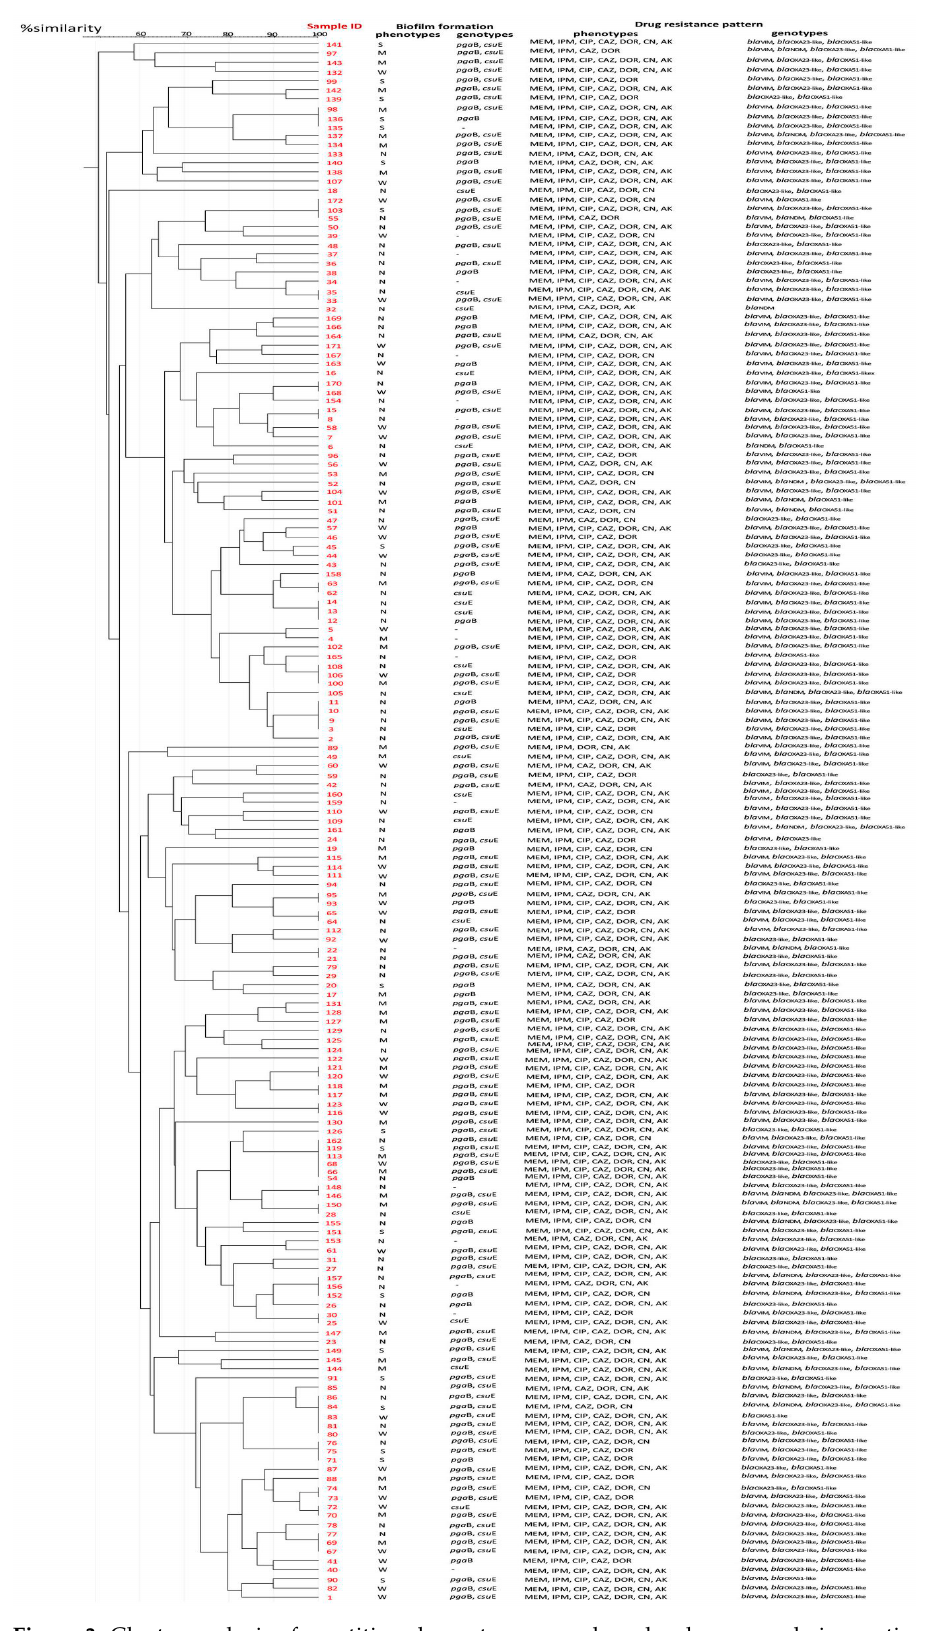
Figure 3. Cluster analysis of repetitive element sequence-based-polymerase chain reaction fingerprints of carbapenem-resistant A. baumannii isolates. The dendrogram was generated using GelJ cluster analysis software and the Unweighted Pair Group Method with Arithmetic Mean.